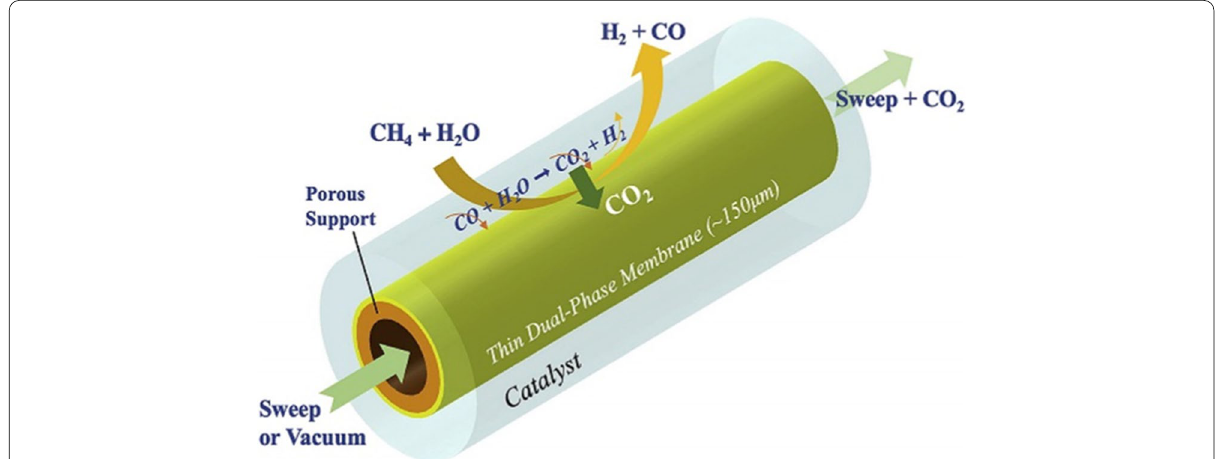
Fig. 17 Schematic of supported carbonate membrane reactor for SMR reaction